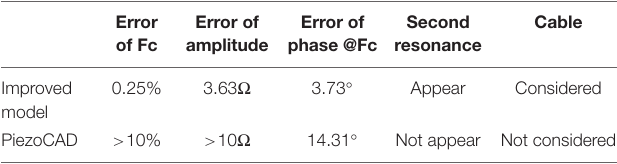
TABLE 3 | The comparison of the improved model and PiezoCAD. Error Error of Error of Second Cable of Fc amplitude phase @Fc resonance Improved 0.25% 3.63 (cid:127) 3.73 ◦ Appear Considered model PiezoCAD 14.31 ◦ Not appear Not